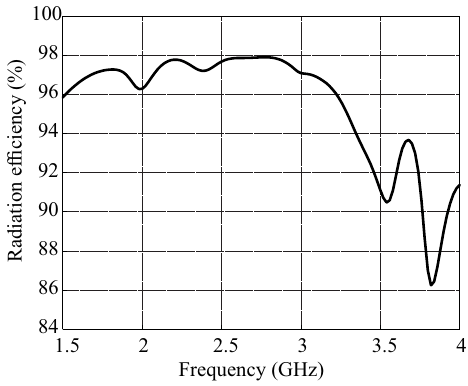
Figure 13. Simulated radiation efficiency of the proposed